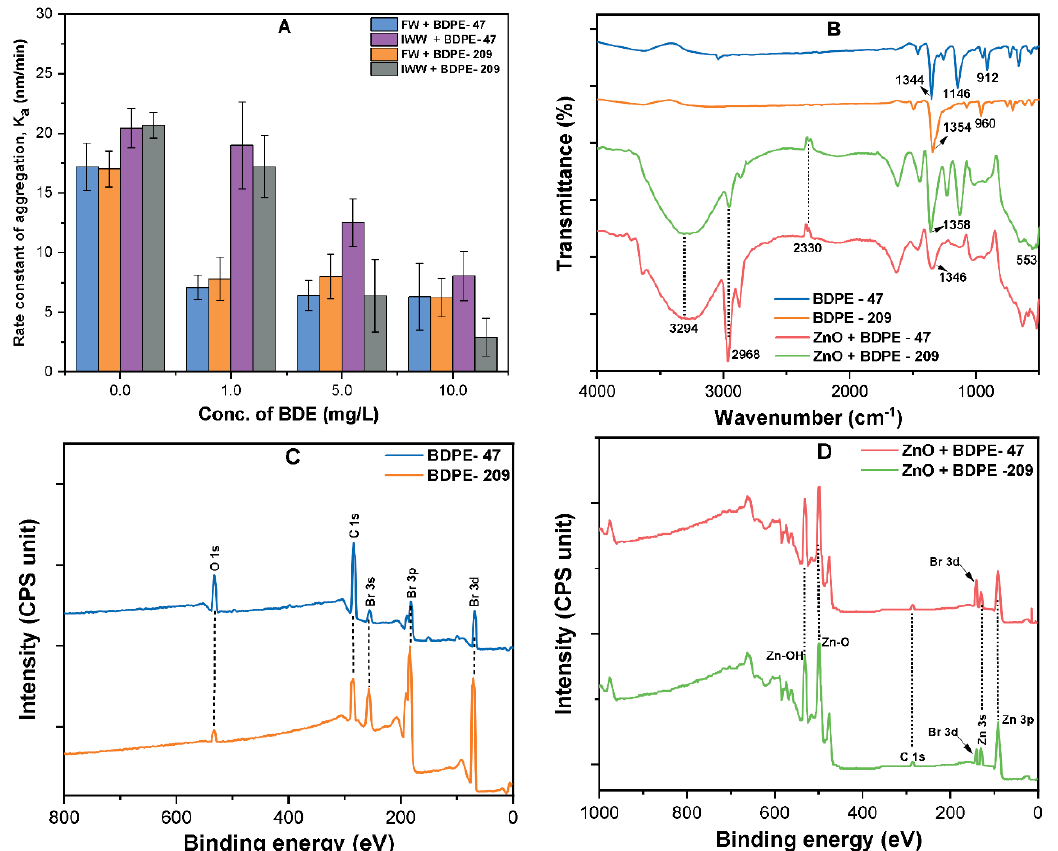
Figure 5. ( A ) Aggregation rate constant ( k a ) of ZnO NPs at various concentrations (0–10 mg/L) of both BDPEs in FW and IWW; ( B ) FT-IR spectra of both pristine BDPEs and ZnO NPs coated with BDPE-47 and BDPE-209; ( C ) XPS survey spectra of both BDPEs; and ( D ) ZnO NPs coated with BDPE-47 and BDPE-209.